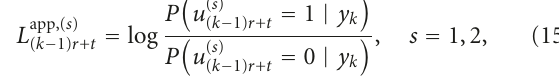
Figure 8: SNR comparison of the WZC and MD-WZC schemes.